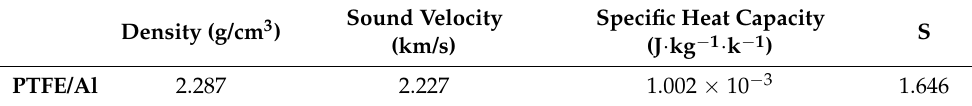
Table 2. Material density, sound velocity, specific heat capacity, and Hugoniot coefficient of PTFE and